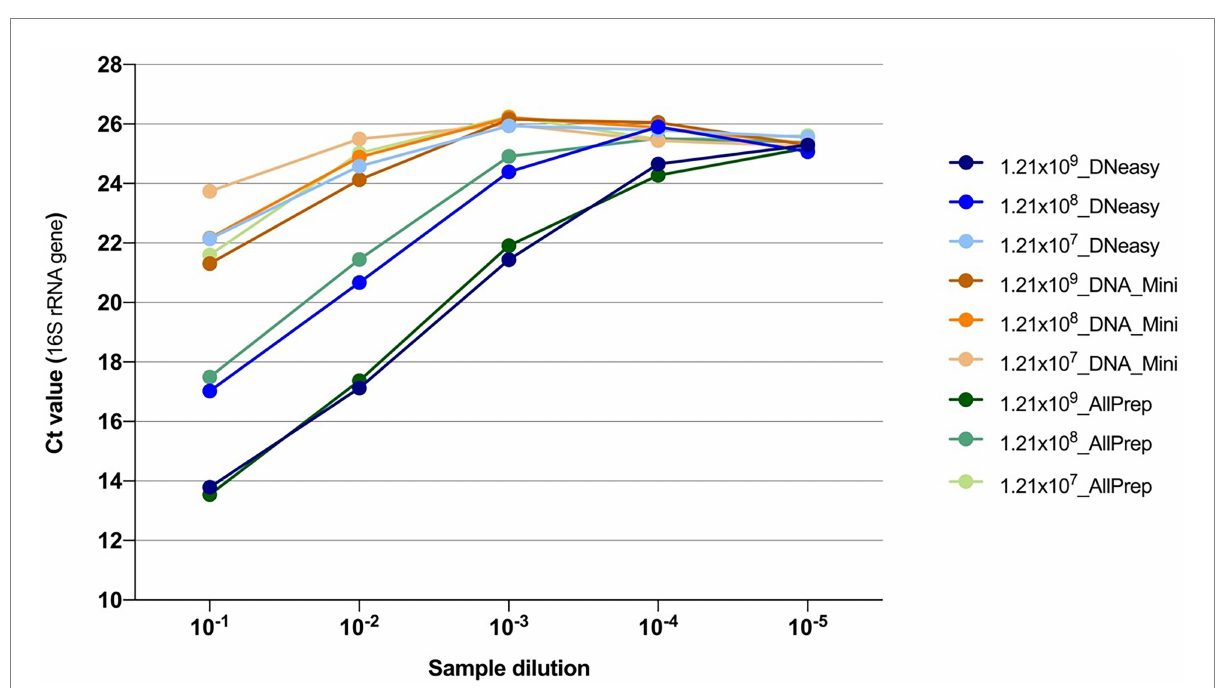
FIGURE 2 Quantification of the 16S rRNA gene using qPCR from DNA extractions. Colors indicate the combination of the concentration of the bacteria and the kit used for extracting the DNA. After extraction, DNA samples were 10-fold serially diluted, and five dilutions were subsequently